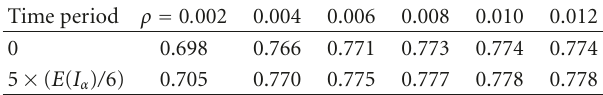
Table 3: The expected success probability of the second